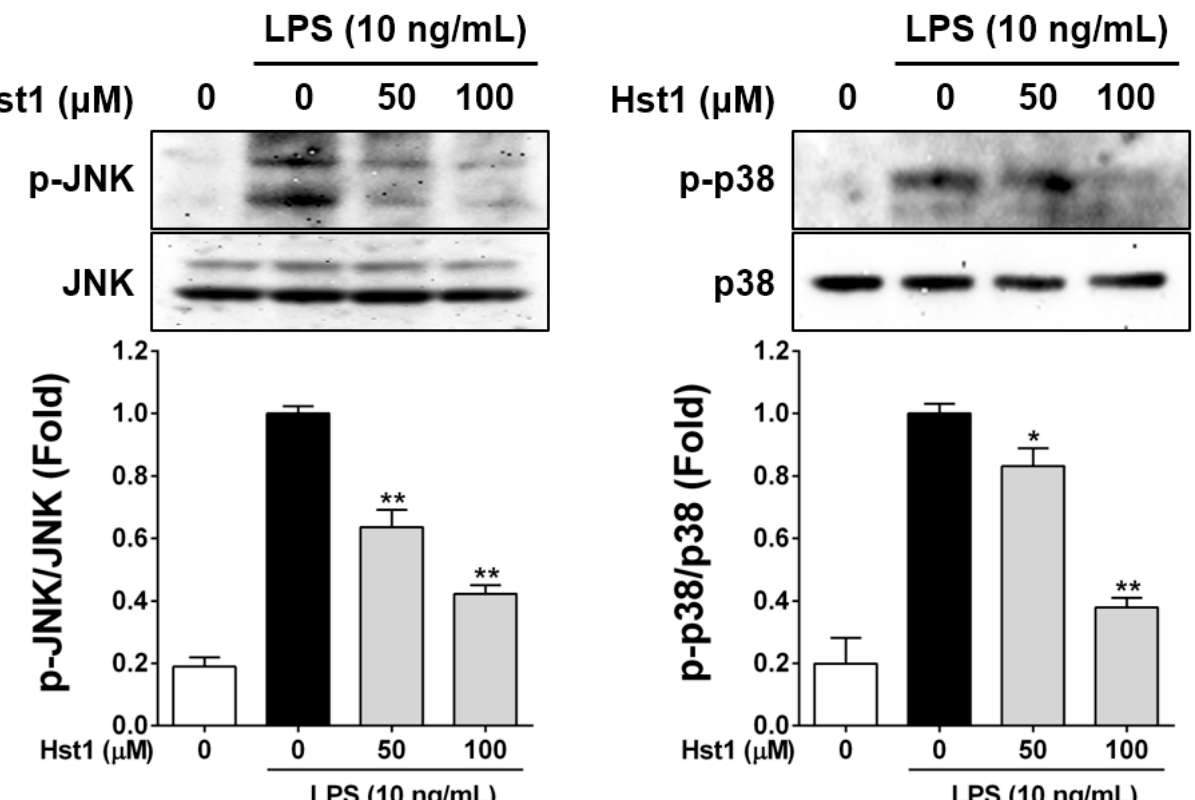
Figure 3. Effects of Hst1 on LPS-induced phosphorylation of MAPKs in RAW264.7 cells RAW264.7 cells were starved for 6 h and then pre-treated with HST1 at the indicated concentrations (50 and 100 µ M) for 2 h and then exposed to HST1 with LPS (10 ng/mL) or LPS alone for 2 h. Whole-cell lysates were analyzed by Western blot analysis using specific phospho-JNK and phospho-p38 antibodies. The blot was stripped and reprobed with an antibody against non-phospho antibodies. Non phospho-JNK and p38 served as the control for the normalization of each MAPKs protein expression. These results are displayed in fold of LPS alone samples. The results of this analysis indicate that Hst1 treatment reduces LPS-induced phosphorylation of JNK and p38 in RAW cells by Hst1, in a dose-dependent manner. Each value represents the mean ± SD and is representative of results obtained from three independent experiments. * p < 0.05 and ** p < 0.01 compared to treatment with LPS alone.